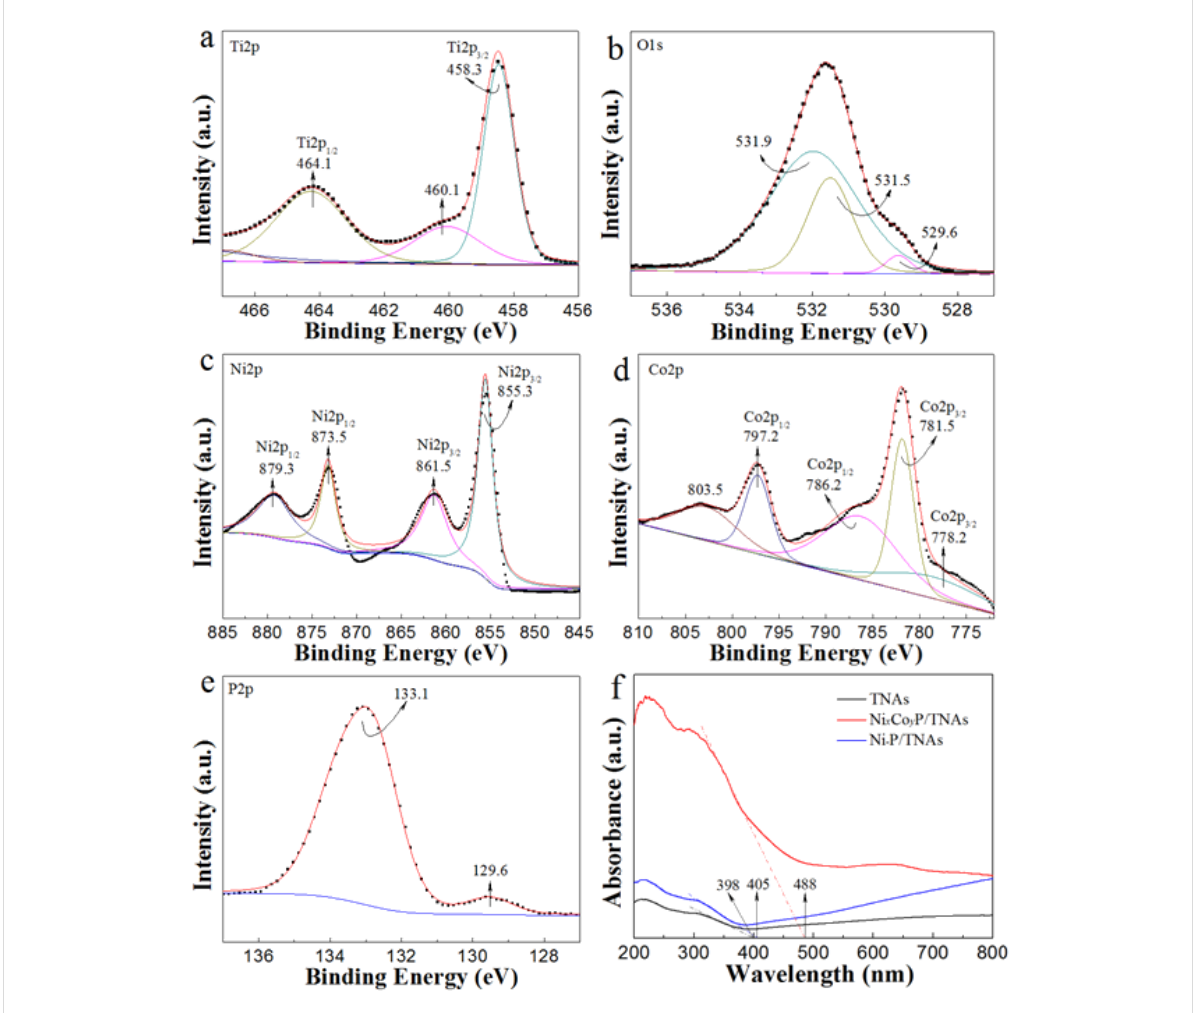
Figure 5: High-resolution XPS spectra of (a) Ti 2p, (b) O 1s, (c) Ni 2p, (d) Co 2p and (e) P 2p of the Ni x Co y P/TNAs. (f) UV–vis diffuse reflection absor- bance spectra of the samples.